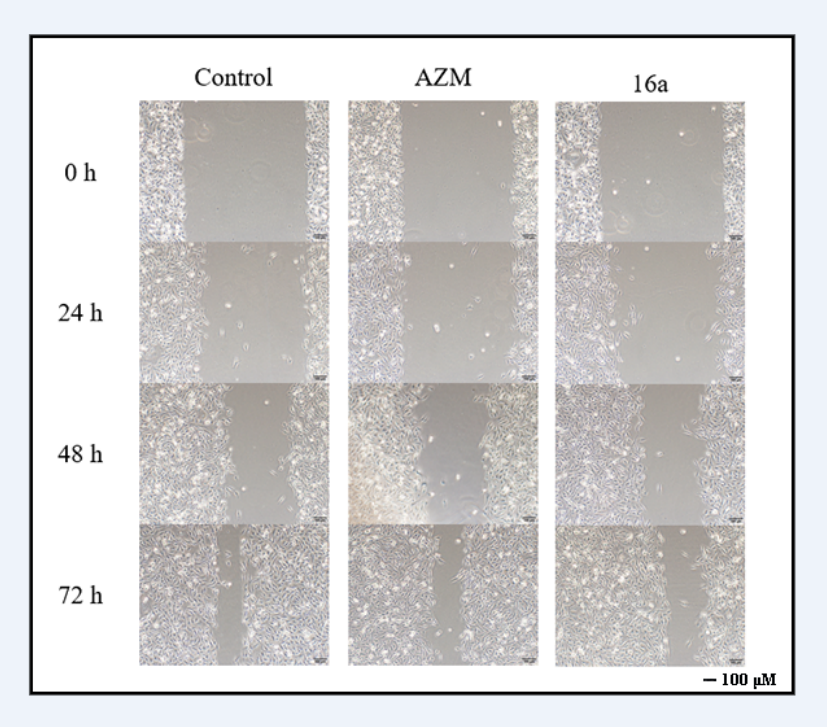
Figure 5. The inhibitory effect of 16a at a concentration of 400 μ M on the migration of MDA-MB-231 cell in vitro.